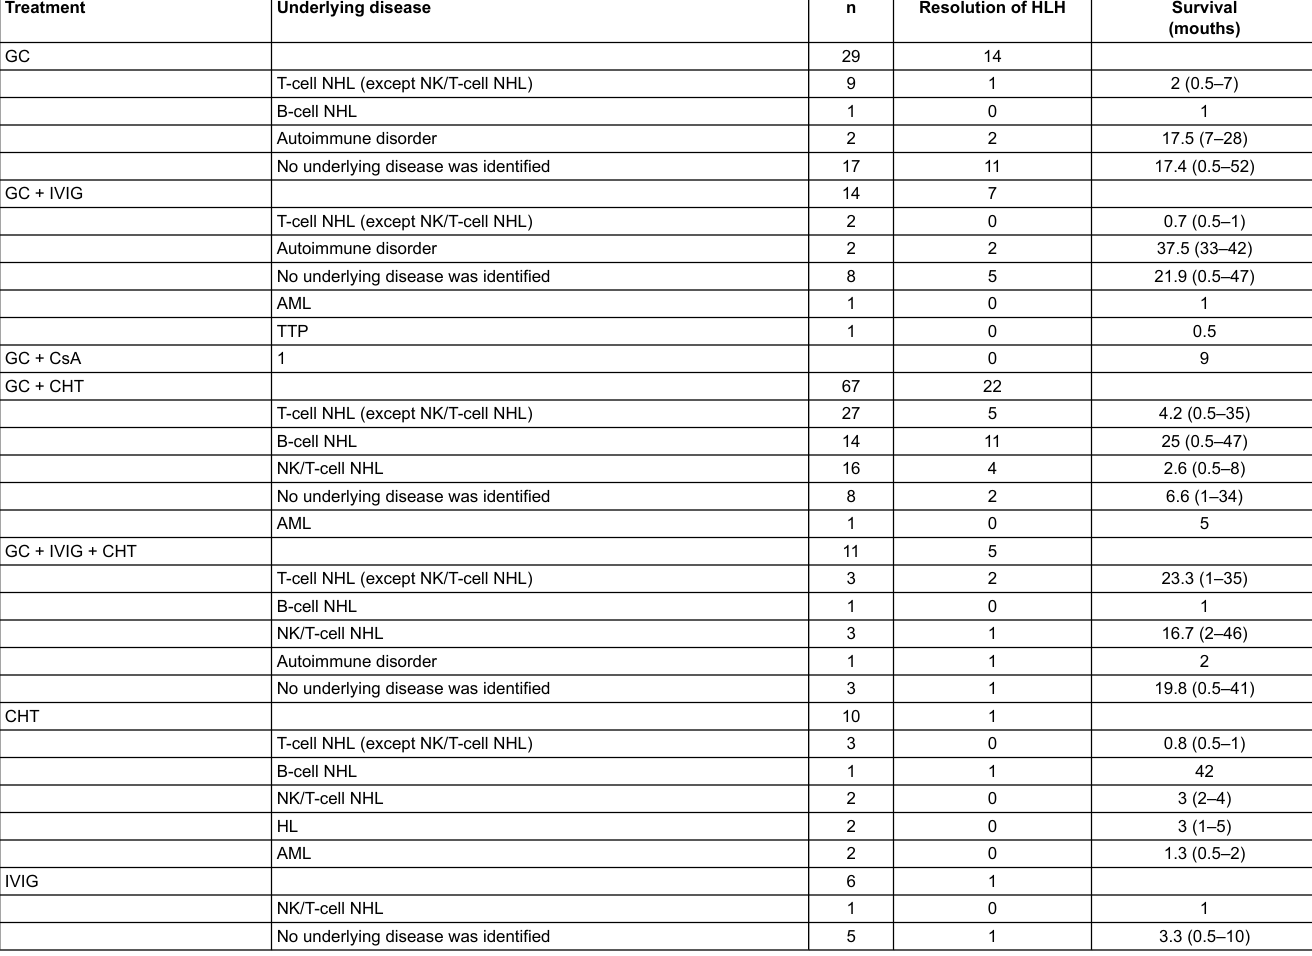
Table 2: Treatment, responses of HLH and the underlying haematological disease to treatment, and HLH outcome. Treatment Underlying